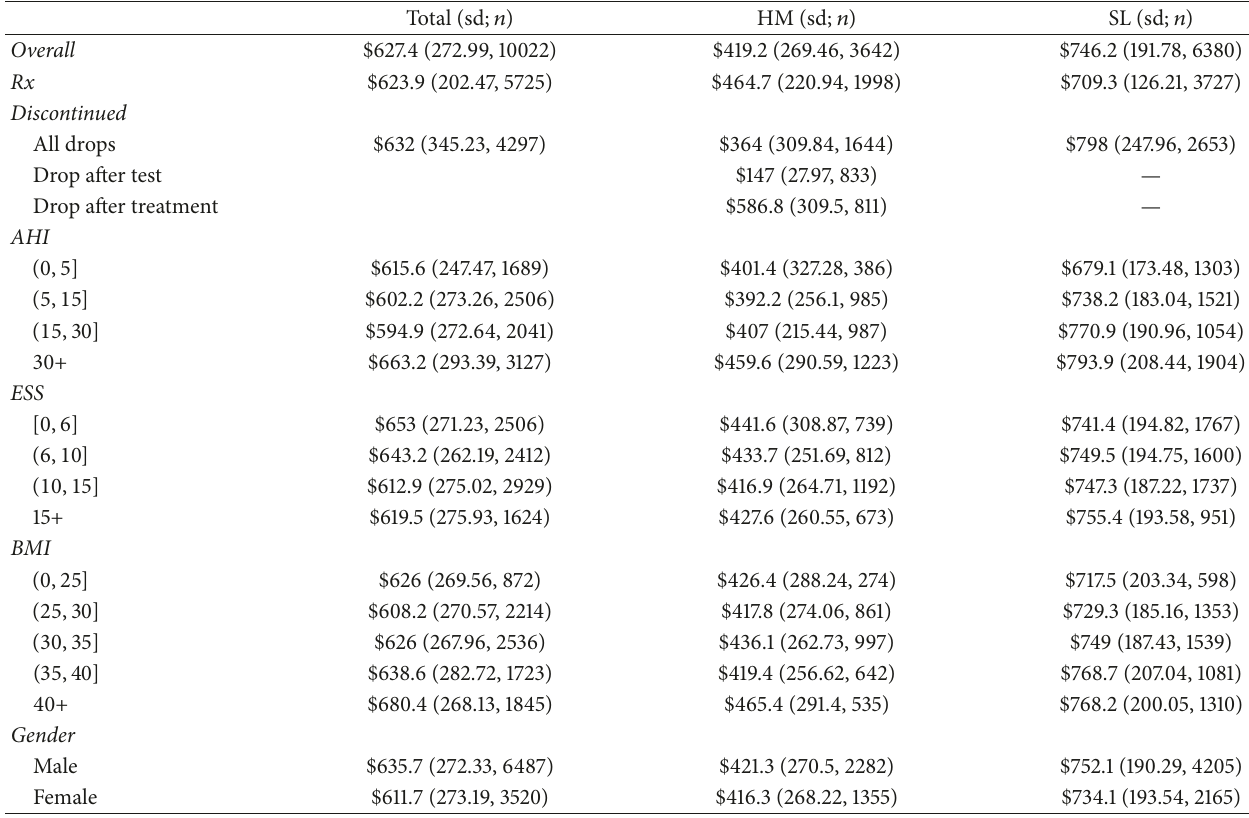
Table 3: Costs of the HM and PSG arms of the program (in Canadian Dollars), overall and stratified by final disposition, AHI, ESS, gender, and BMI. Rx represents the costs for patients that get a prescription, and discontinued represents those patients that left the program before they received a diagnosis, because of either a negative test or a decision to not pursue treatment.